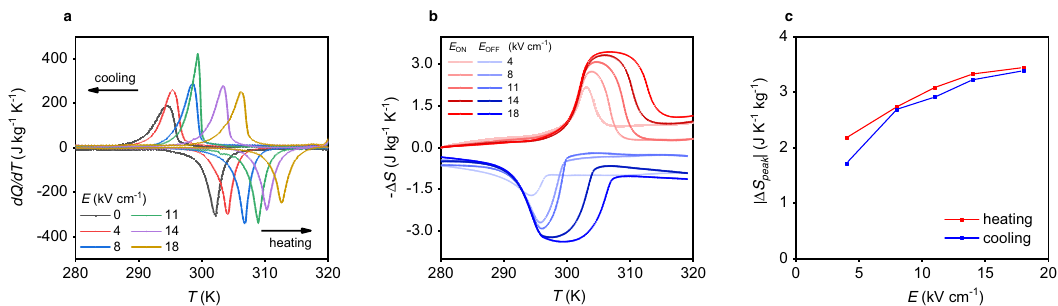
Fig. 2 Iso fi eld measurements in PST. a Iso fi eld heat fl ow measurements d Q /d T as a function of temperature T at different electric fi elds E on heating and cooling. b Isothermal entropy change Δ S obtained from iso fi eld measurements (Methods section) at different electric fi elds, on applying ( E ON ) and removing ( E OFF ) fi eld. c Isothermal entropy change peak | Δ S peak | as function of electric fi eld E , on cooling (blue curves) and heating (red curves).